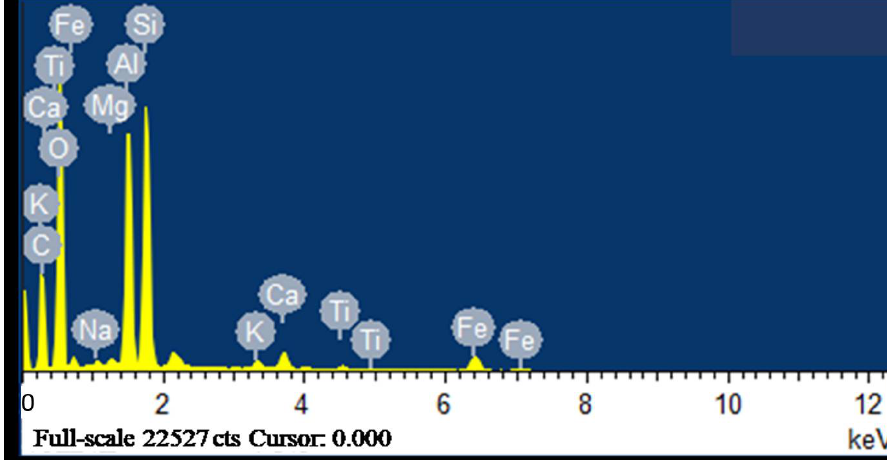
Figure 5. EDS analysis result for fly ash.